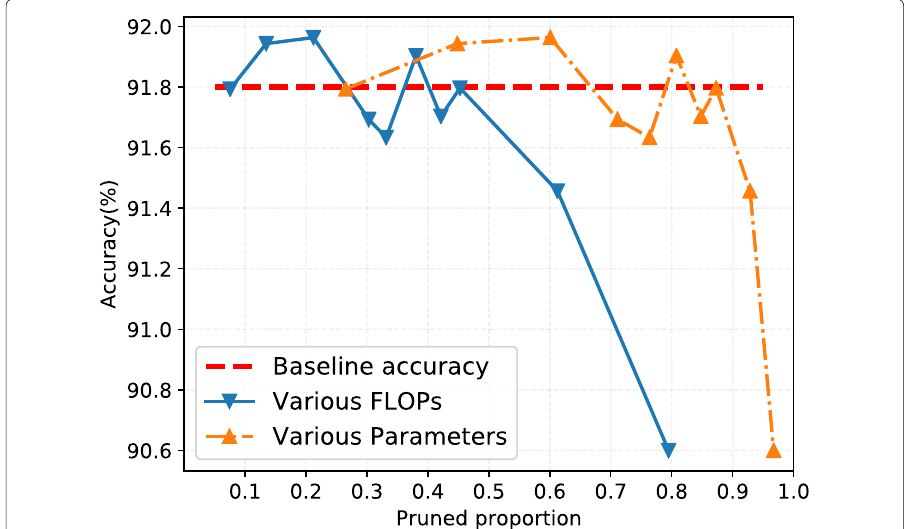
Fig. 8 Pruning MobileNet on CIFAR-10 with the compression-rate varying from 0.0 to